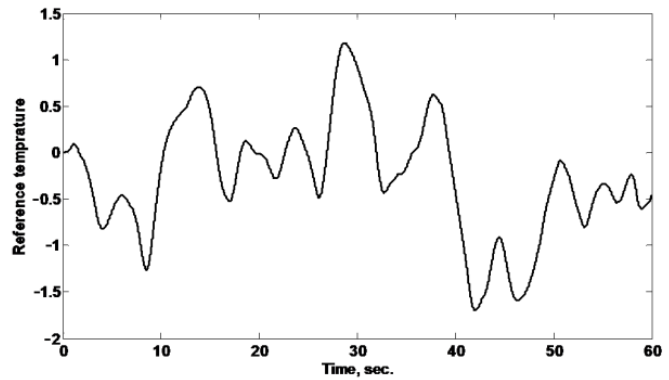
Figure 11. Random reference temperature.